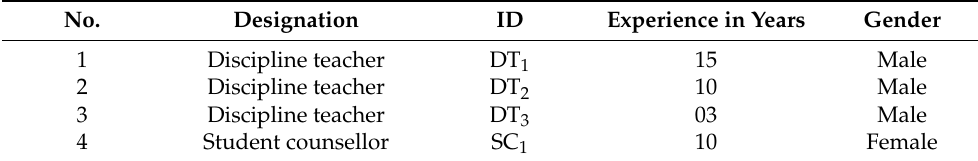
Table 1. Participants in qualitative data